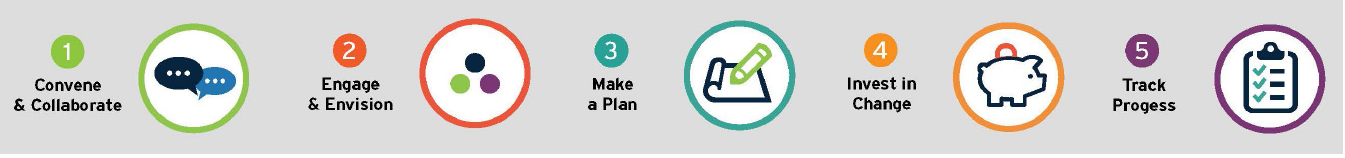
Figure 1. Five Key Strategies for communities to adapt and implement HiAP